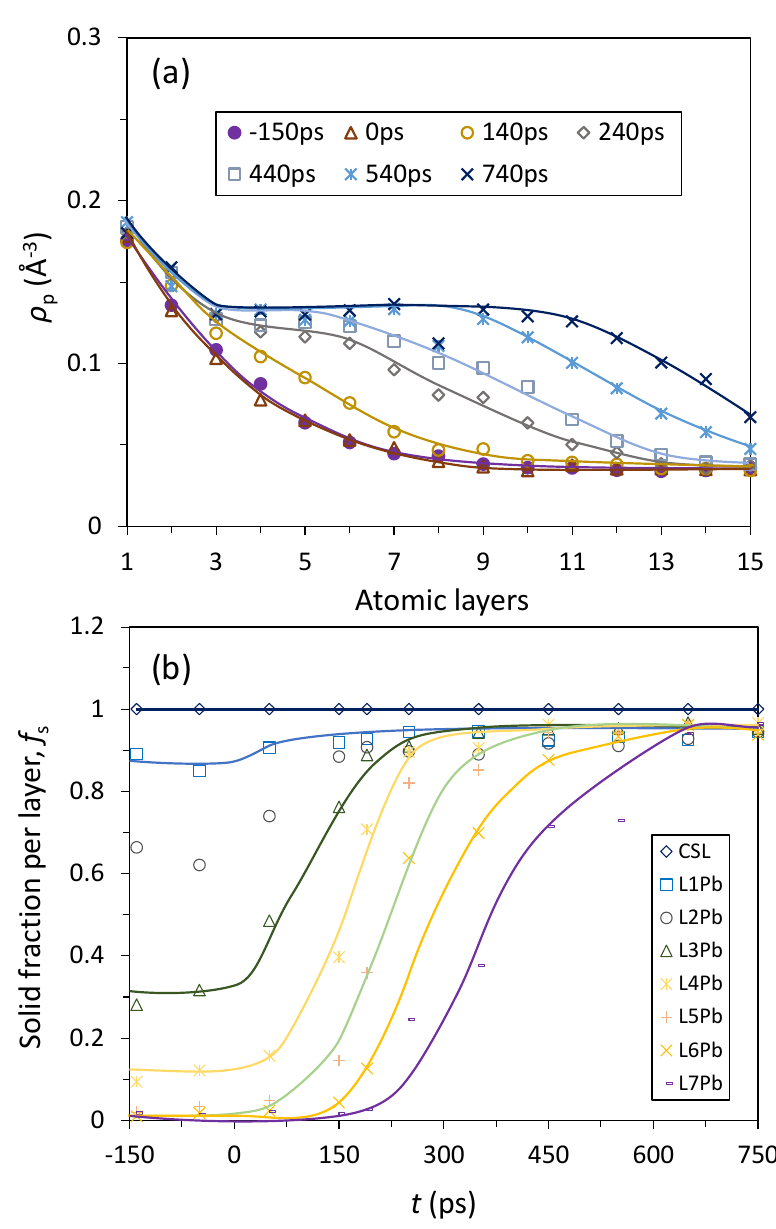
Figure 7. Evolution of atomic ordering during heterogeneous nucleation in the Pb( l )/Cu( s ) system at T n = 594 K; ( a ) Peak density, ρ p ( z ), and ( b ) solid fraction, f s ( z ), of the individual Pb layers at the interface are plotted as functions of t and the atomic layer away from the interface.